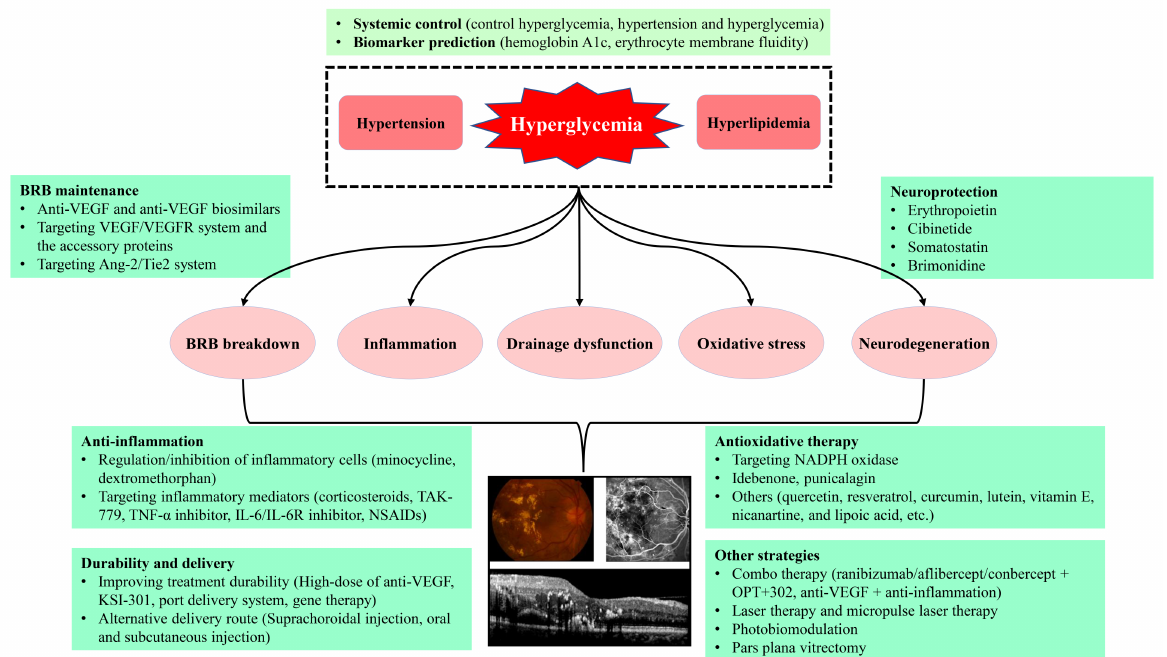
Figure 1. The proposed diagram for the pathogenesis and treatments of DR and DME. Anti-VEGF, anti-vascular endothelial growth factor; Ang-2, angiopoietin 2; DME, diabetic macular edema; DR, diabetic retinopathy; IL-6, interleukin 6; IL-6R, interleukin 6 receptor; NADPH, the reduced form of nicotinamide adenine dinucleotide phosphate; NSAIDs, nonsteroidal anti-inflammatory drugs; Tie2, tyrosine kinase with immunoglobulin-like and epidermal growth factor-like domains 2; TNF- α , tumor necrosis factor α ; VEGF, vascular endothelial growth factor; VEGFR, VEGF